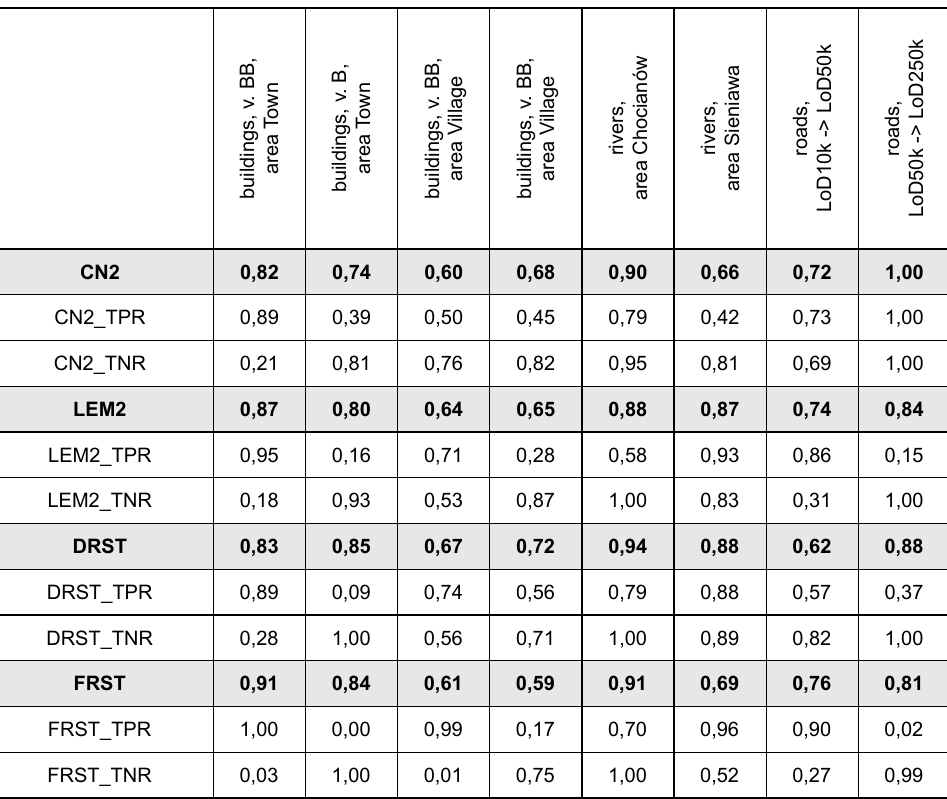
Table 4. Collected results for real data (source: A. Fiedukowicz 2017)